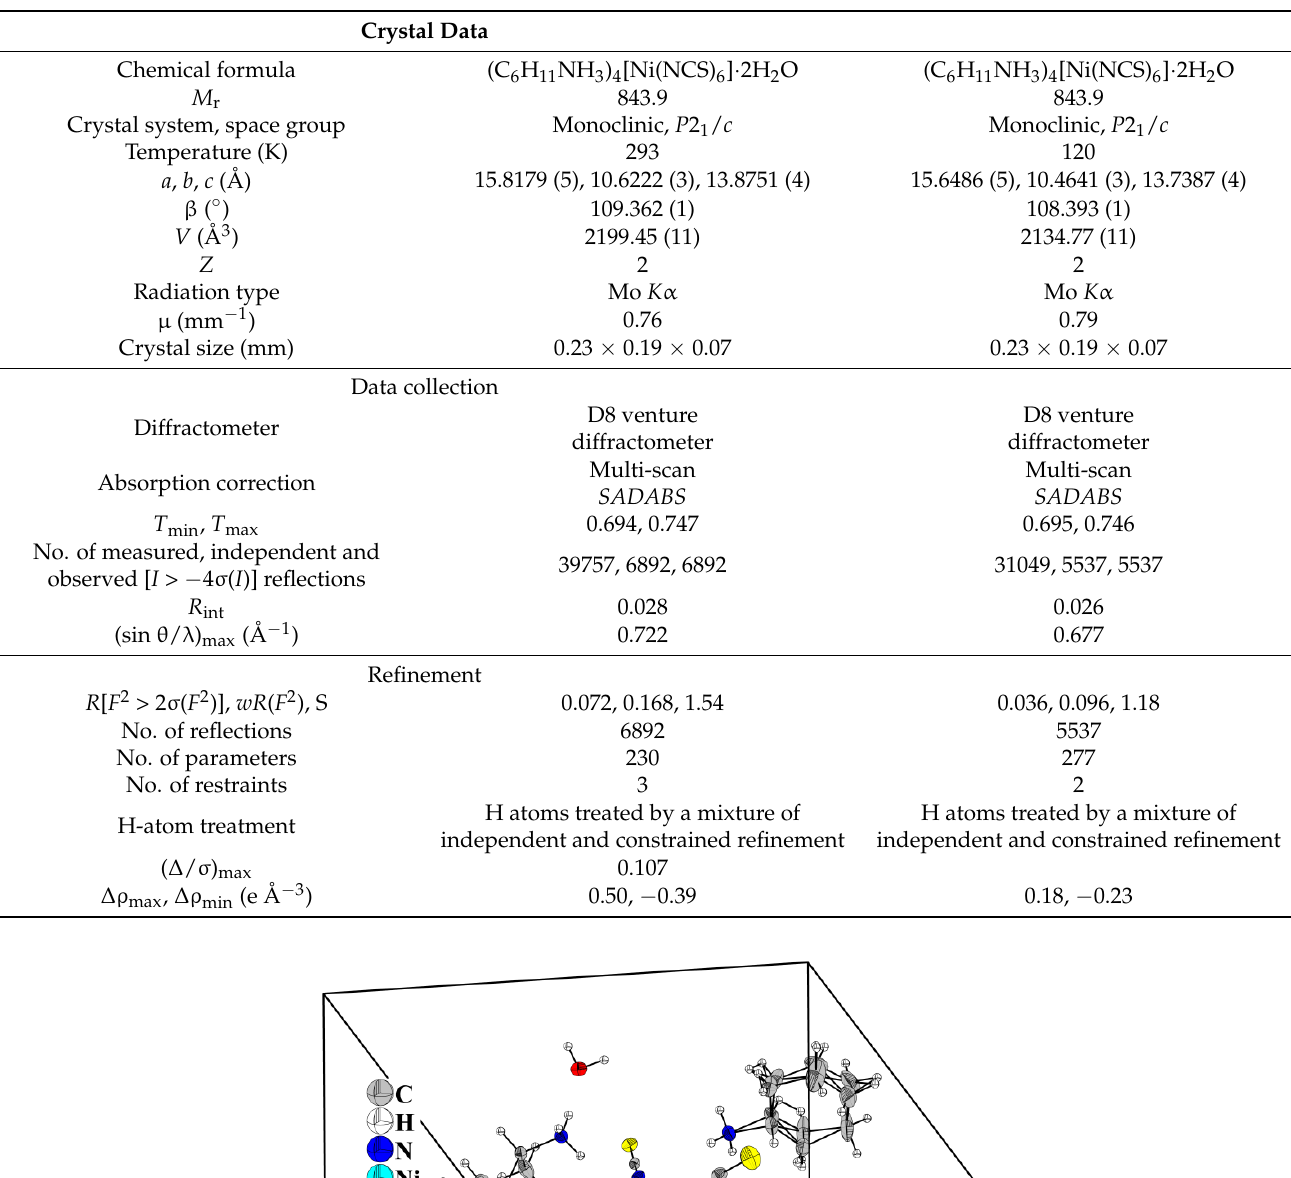
Table 2. Experimental details.